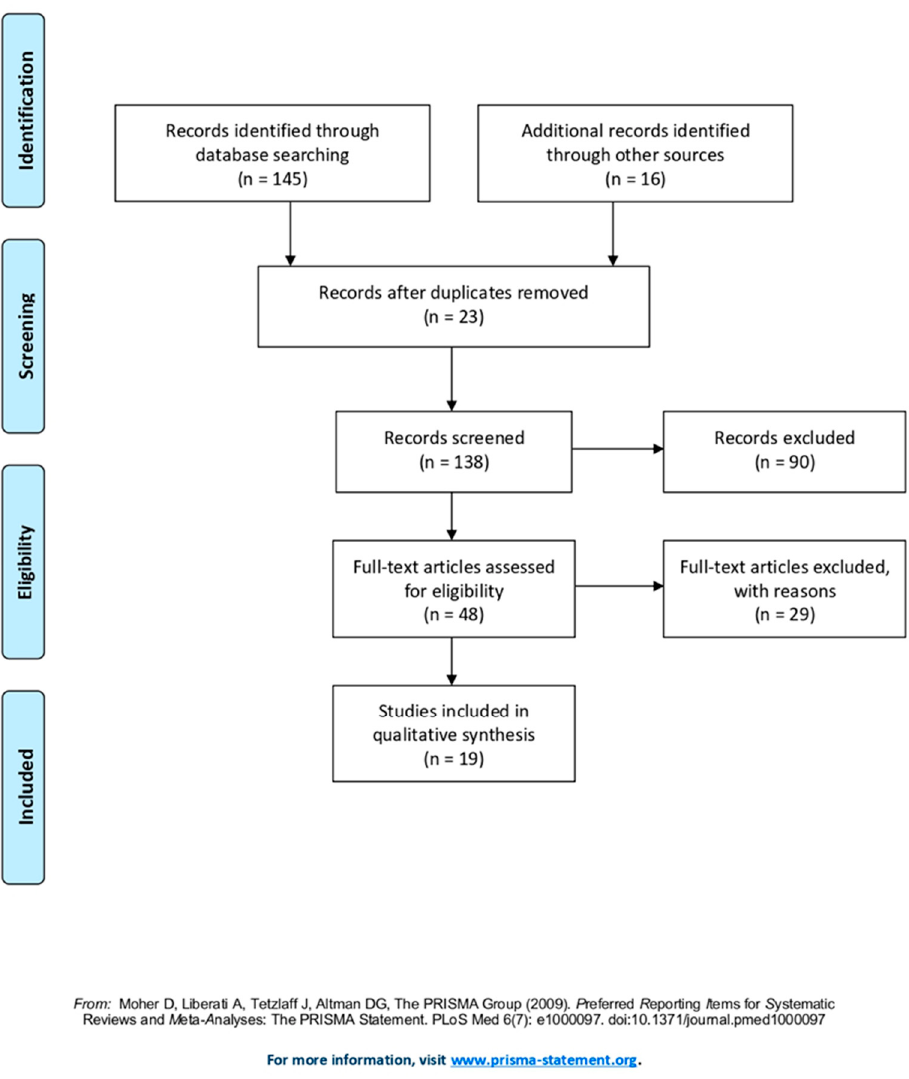
Figure 1. PRISMA 2009 Flow Diagram© of study selection process of literature (from Moher, D.;